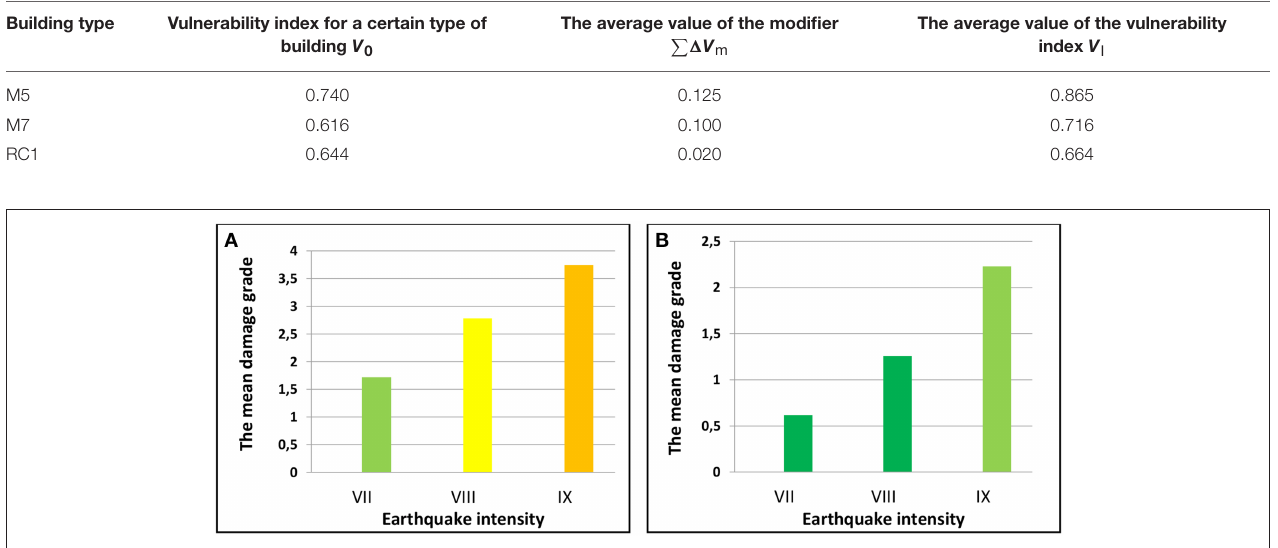
damage grades are displayed in the program package QGIS, for intensity VII, VIII, and